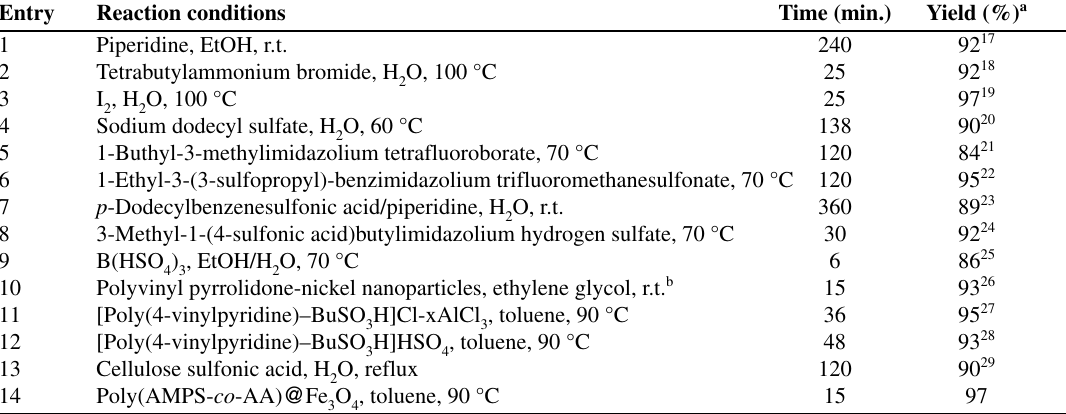
O with other catalysts reported in the literature in the condensation of 3 4